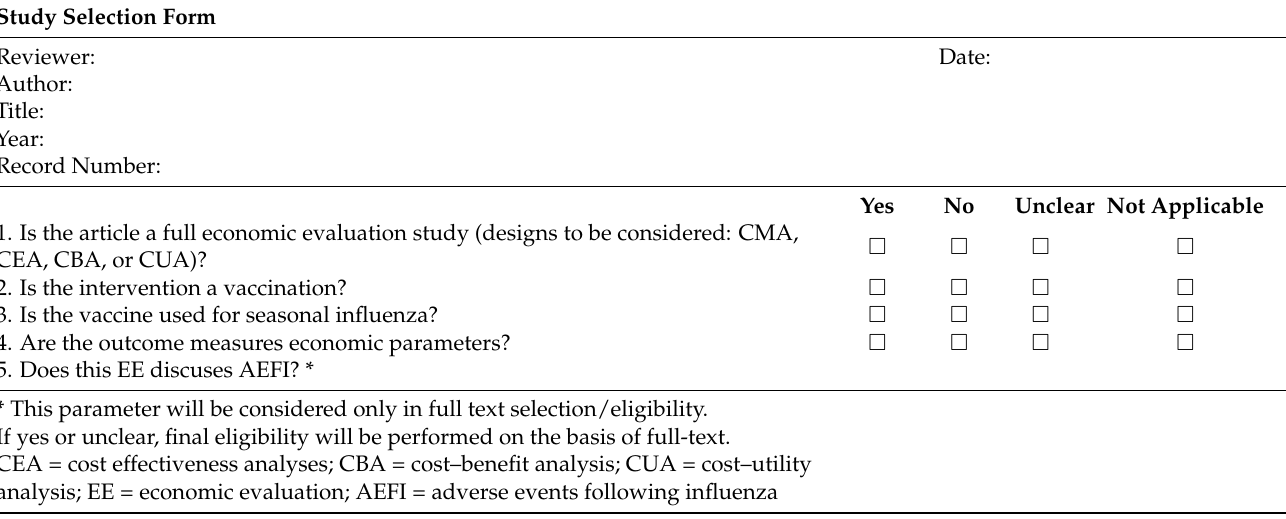
Table A1. Study Selection Form.